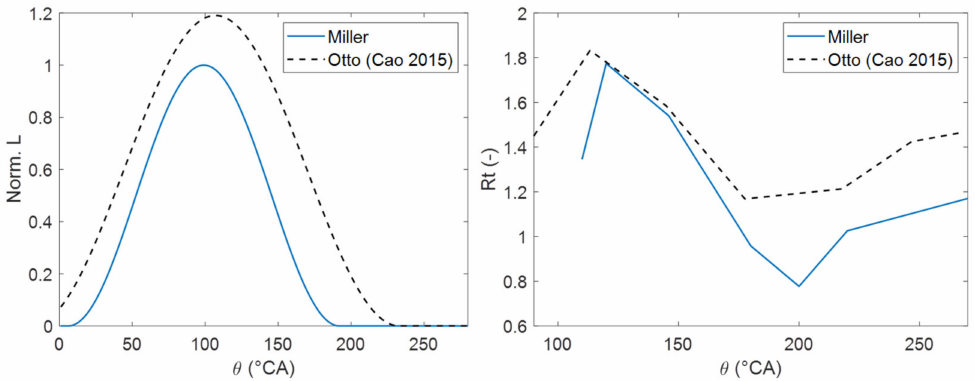
Figure 16. Miller effect on R t .